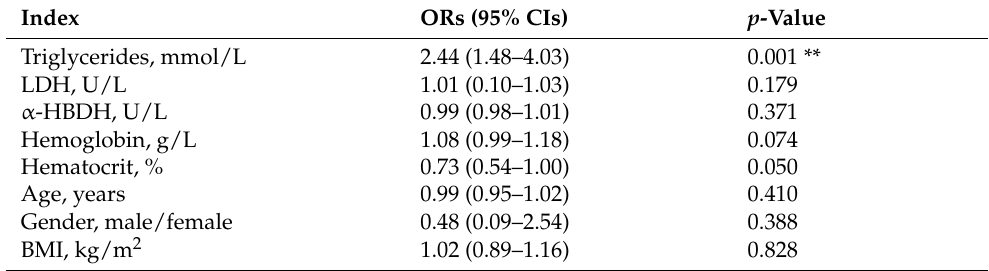
Table 4. Binary logistic regression analysis of risk factors associated with SLE-related kidney